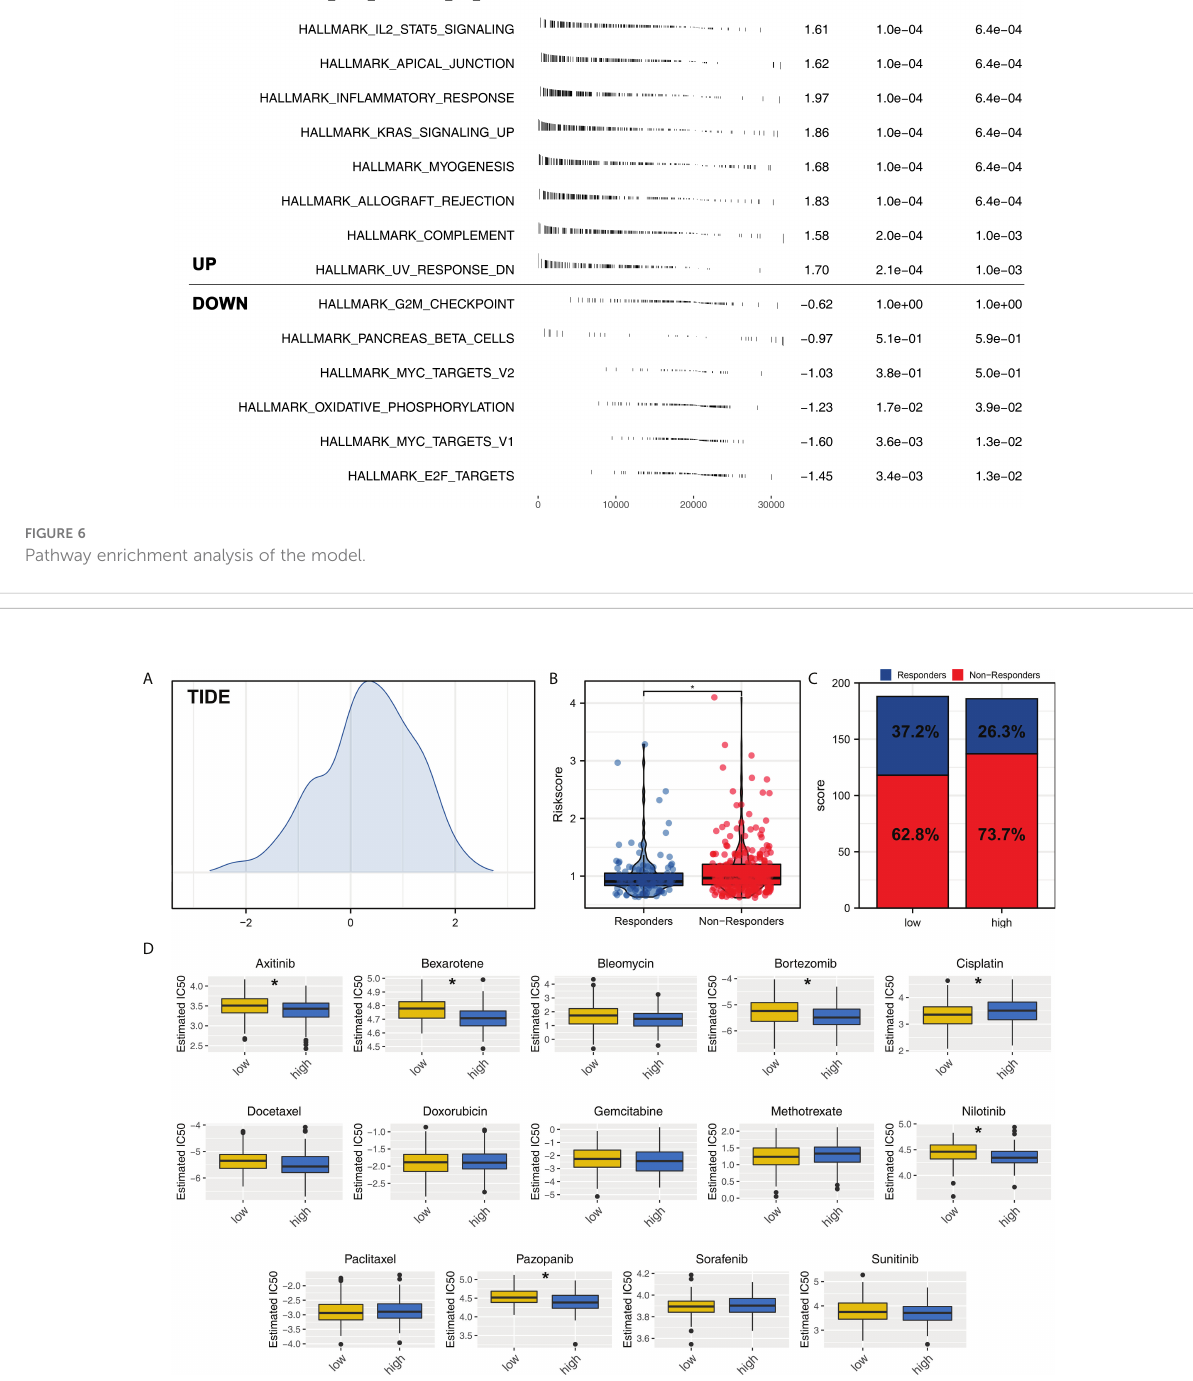
FIGURE 7 Immunotherapy and chemotherapy sensitivity. (A) TIDE analysis was performed to evaluate the immunotherapy response rate of OV patients; (B) The riskscore difference of immunotherapy responders and non-responders; (C) Patients in low risk group tend to have a higher proportion of immunotherapy responders; (D) Chemotherapy sensitivity analysis. *P <